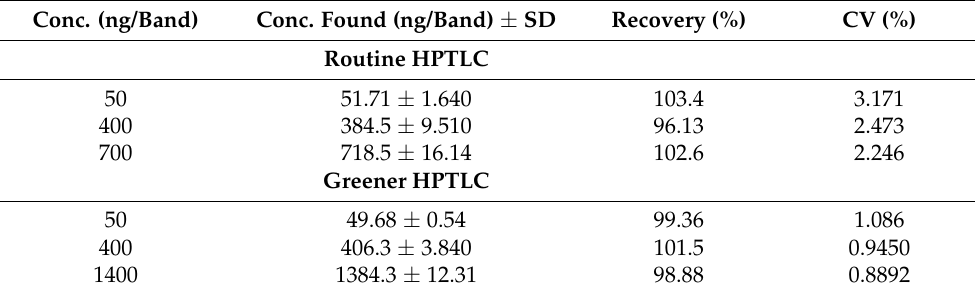
Table 3. The percent recoveries of GFT for the routine HPTLC and the greener HPTLC methods (mean ± SD; n =